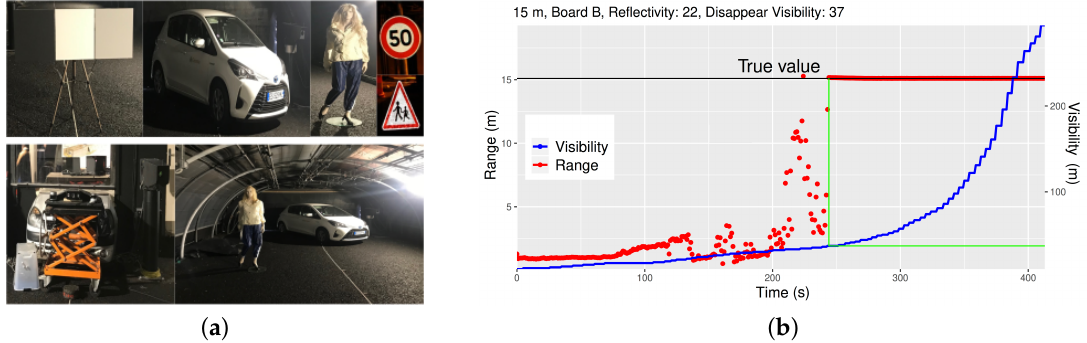
Figure 2. Use case of the Cerema’s Adverse Weather platform for the qualification of a Time of Flight Light Detection And Ranging (ToF LiDAR) [47]. ( a ) Top: used targets (three calibrated boards, vehicle, a dummy model and two traffic signs). Bottom: Velodyne UltraPuck on the table and an example scenario. ( b ) Average range measures (LiDAR detection) with Meteorological Optical Range (MOR) V ( t ) for randomly selected individual lasers of the board B target, at 15 m distance. Disappear visibility is marked as the crossings of green